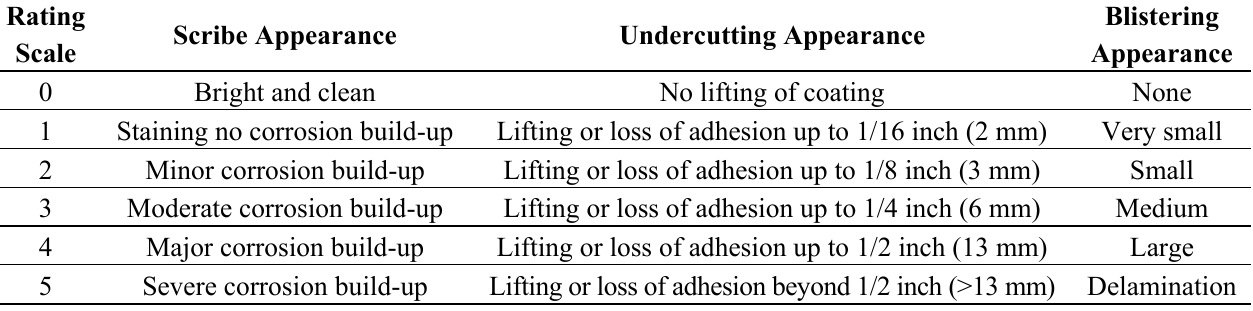
Table 4. Scribe, undercutting and blistering appearance rating